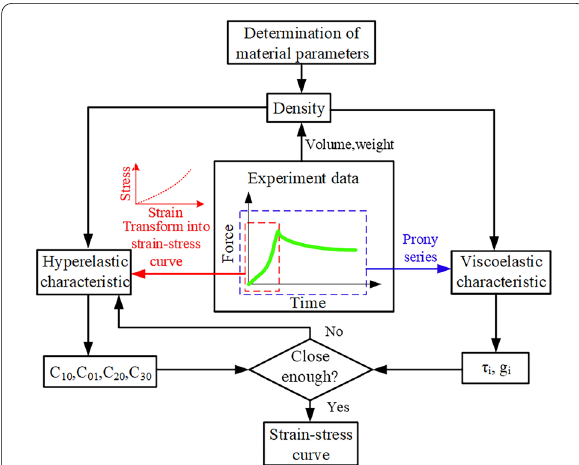
Figure 1 Flowchart to identify the mechanical properties of soft tissue